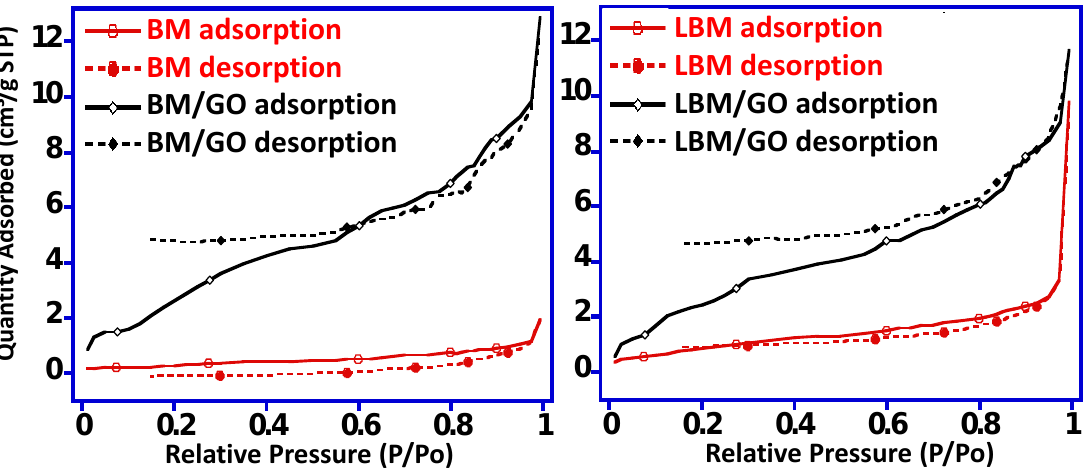
Figure 3. Nitrogen adsorption isotherms of 4% BM/GO and 4% LBM/GO composites.